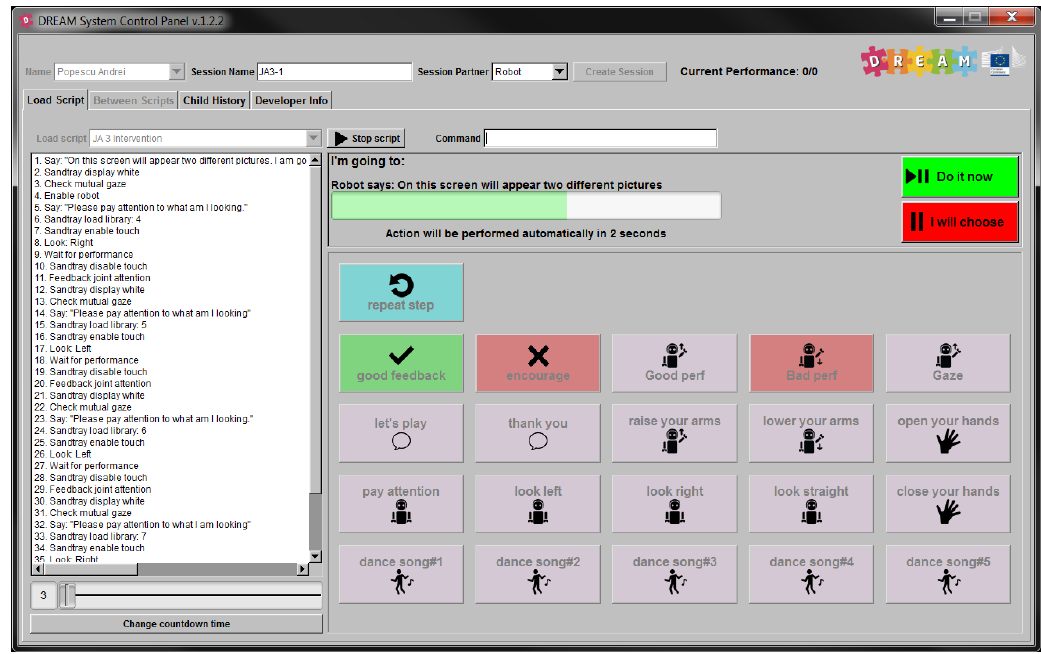
Figure 4: Graphical User Interface (GUI) component used by the therapist to control the robot. On the left side, the script of the intervention protocol is listed. On the right side, a set of robot actions available to overrule the autonomous